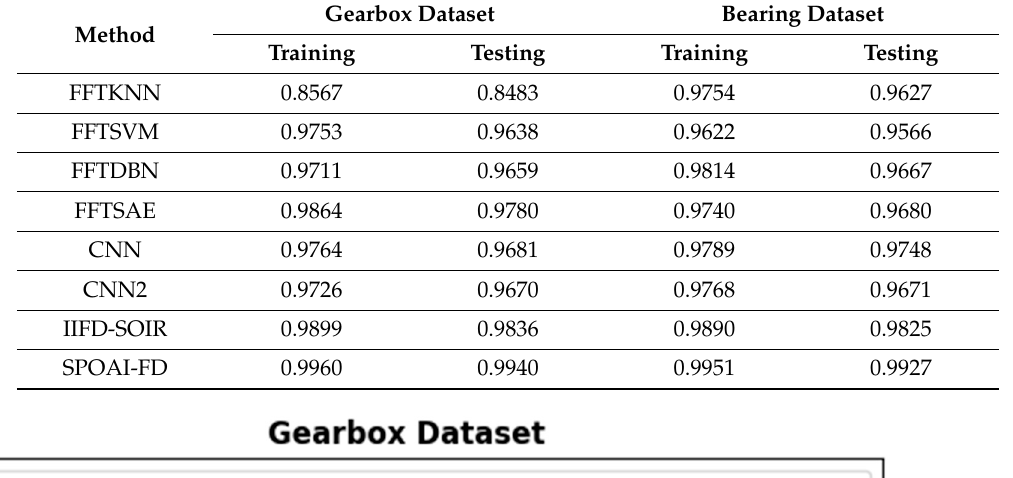
Table 6. Training and testing accuracies of the proposed SPOAI-FD approach and other recent methods.